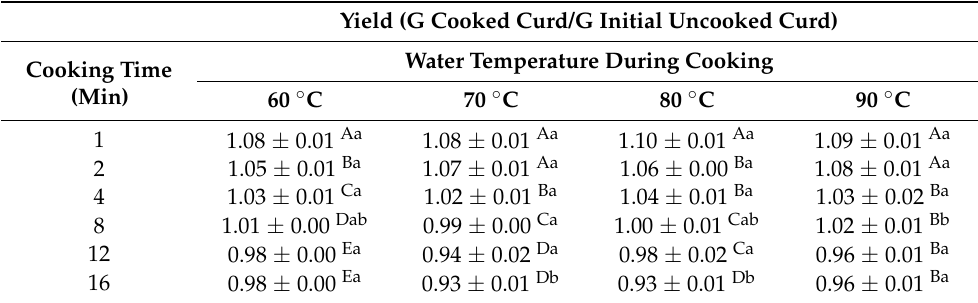
Table 1. Yield (g cooked curd/g initial uncooked curd), reported as means ± standard deviation. Yield (G Cooked Curd/G Initial Uncooked